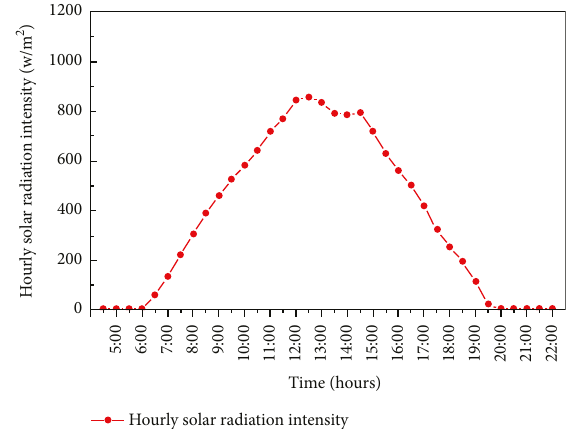
Figure 2: Hourly solar radiation intensity for June 26, 2016, in Chongqing, China